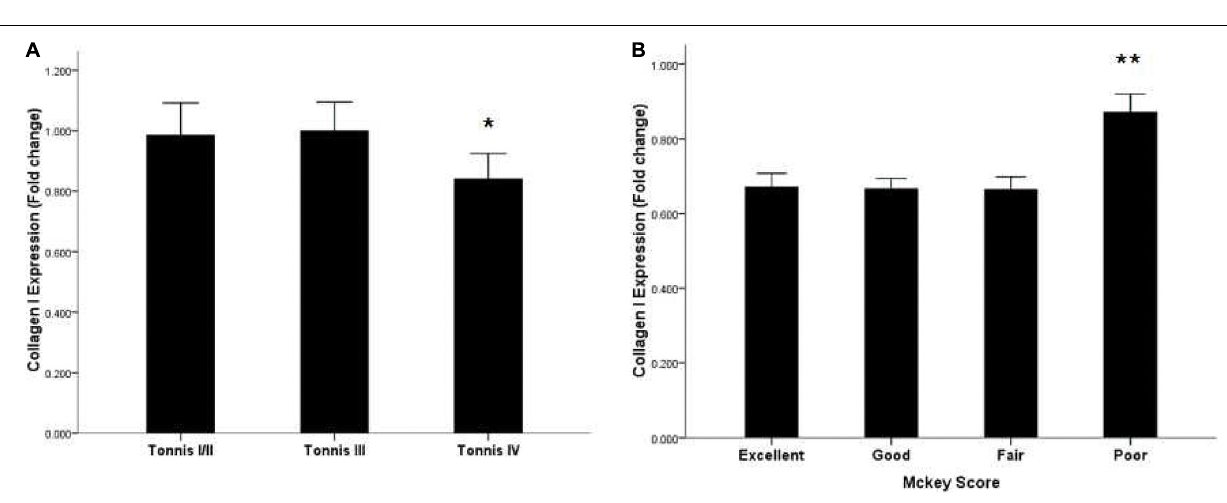
Frontiers in Pediatrics |